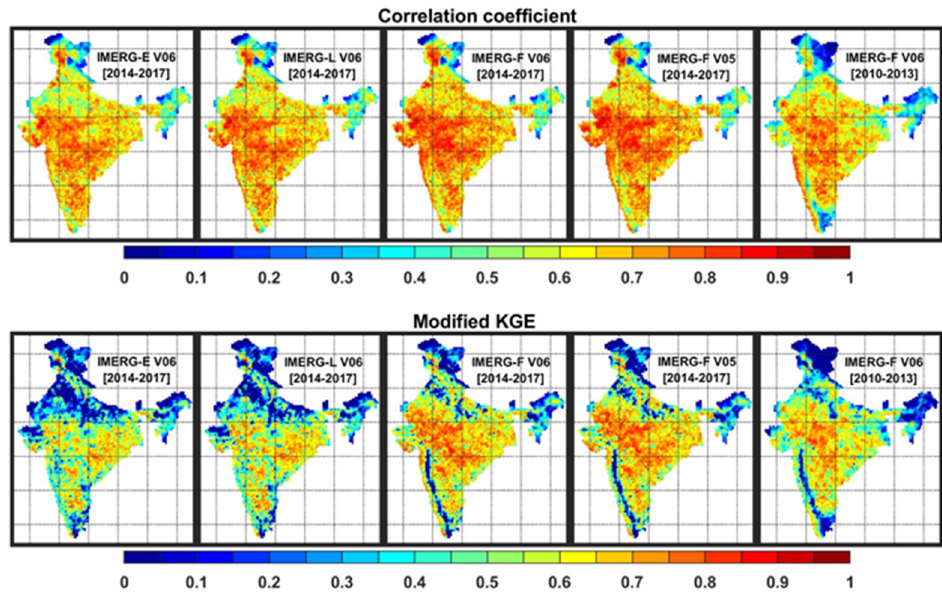
Figure 7. Spatial distributions of correlation coefficient and modified Kling–Gupta efficiency in IMERG estimates as compared to the rain-gauge-based data over India for the GPM (2014–2017) and pre-GPM (2010–2013) periods. Table 3. Error statistics in the IMERG precipitation products as compared to the IMD rain-gauge-based dataset for all-India daily monsoon rainfall estimates.